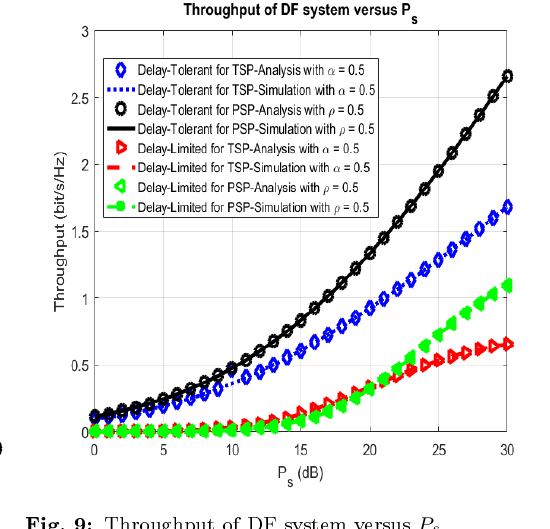
Fig. 9: Throughput of DF system versus P s